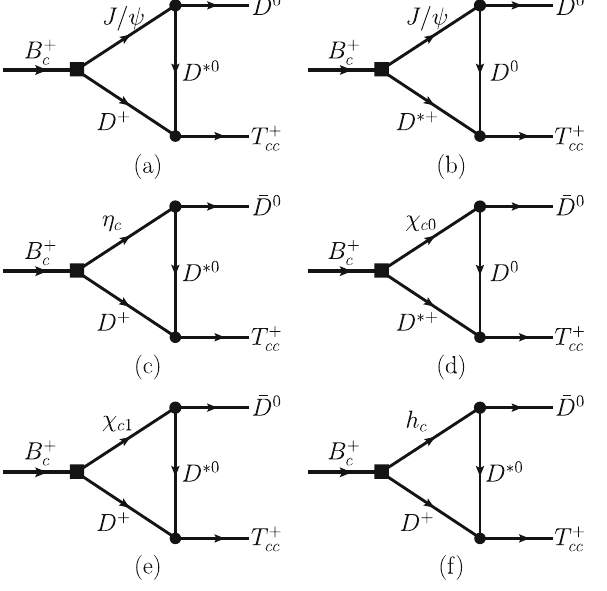
Fig. 1 Rescattering diagrams contributing to B + c → T + cc ¯ D 0 . The boxes and dots represent the weak and strong vertices, respectively ¯ ¯ → T + → T + B + D 0 and B + D ∗ 0 are discussed. A sum- c c cc ¯ s cc ¯ s mary is given in Sect.4.